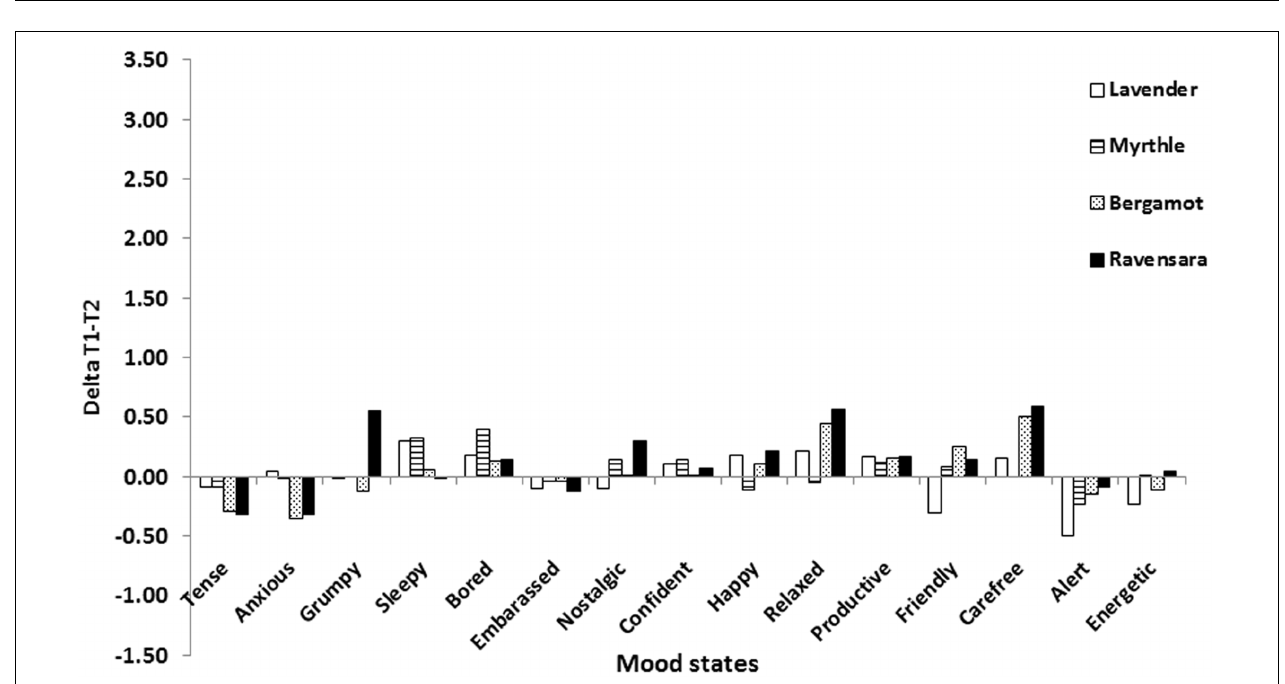
FIGURE 2 | Mean differences in mood state values between T1 and T2 (Delta T1–T2) for each